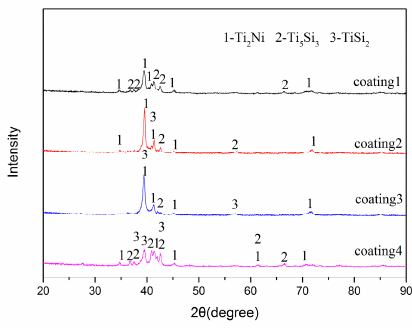
Figure 3. XRD patterns of the coatings.